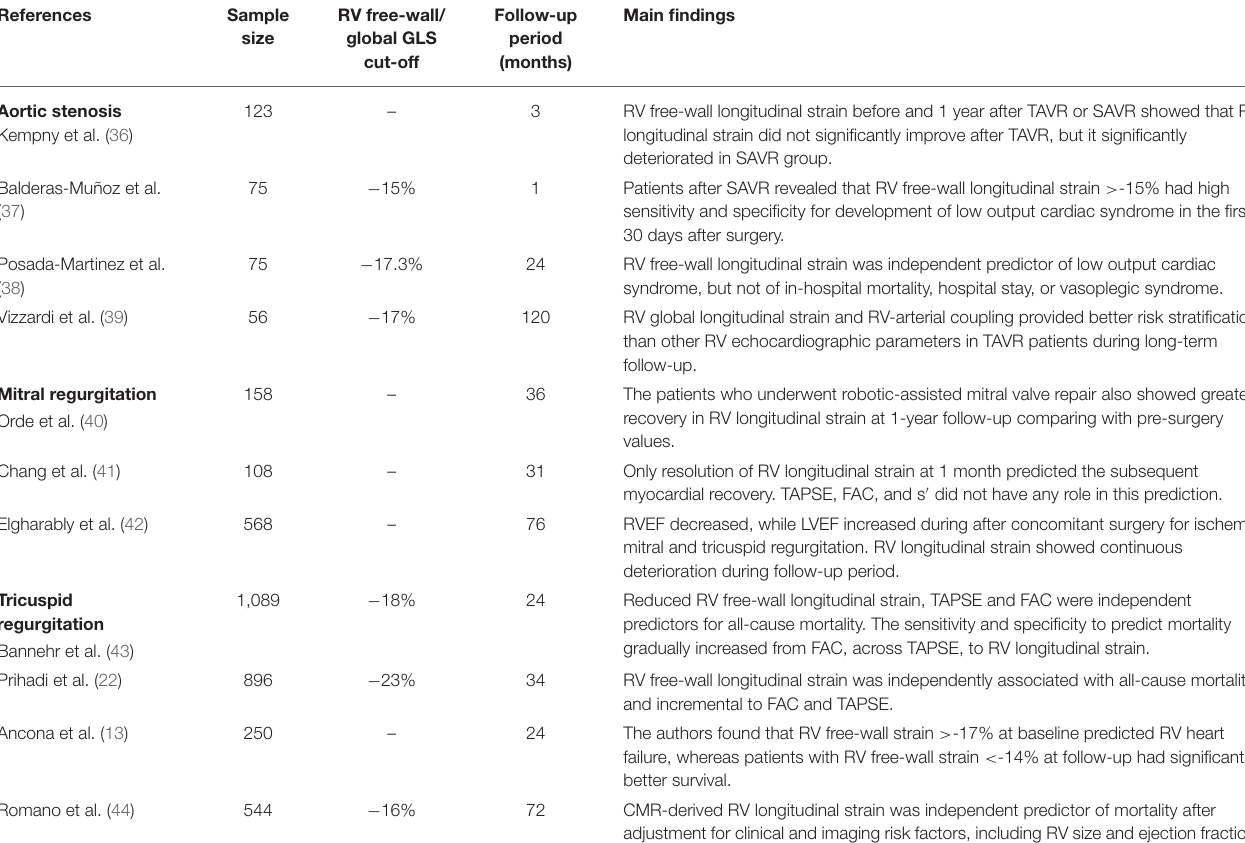
TABLE 4 | Predictive value of RV longitudinal strain in patients with valvular heart